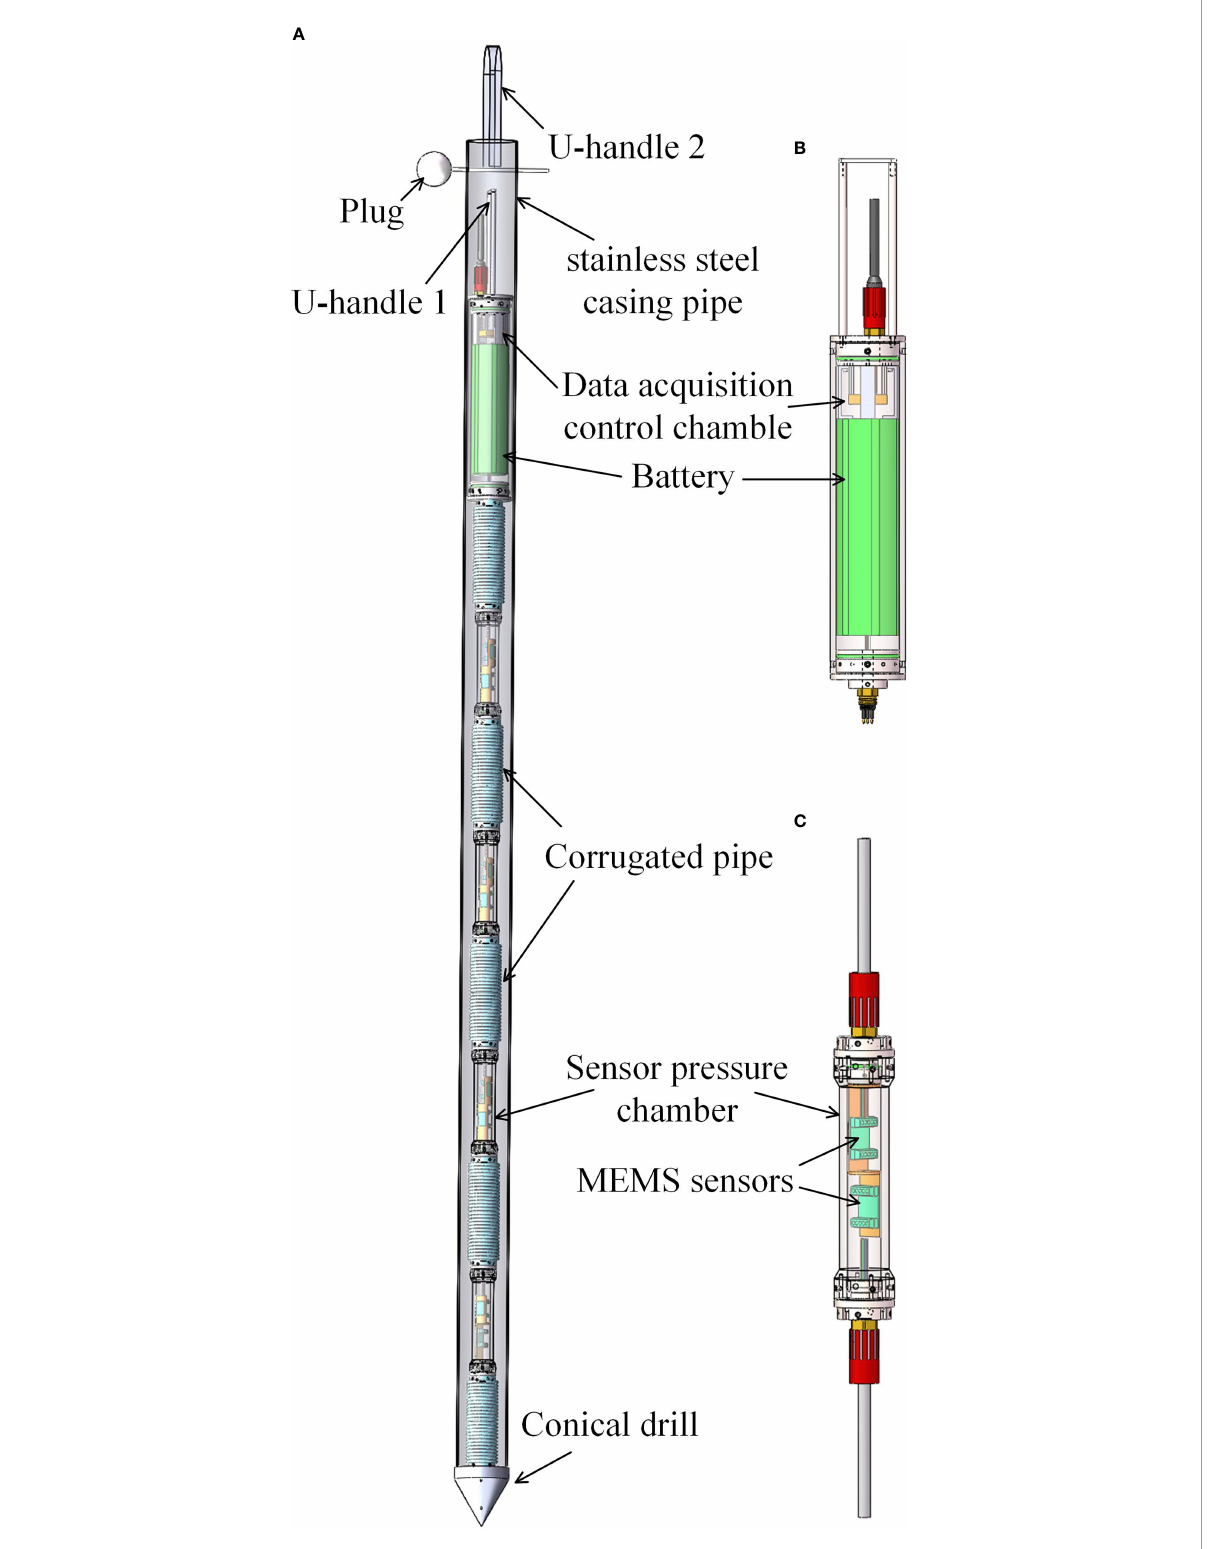
FIGURE 1 The diagram of the monitoring instrument: (A) the overview of the instrument; (B) the data acquisition chamber; and (C) the sensor